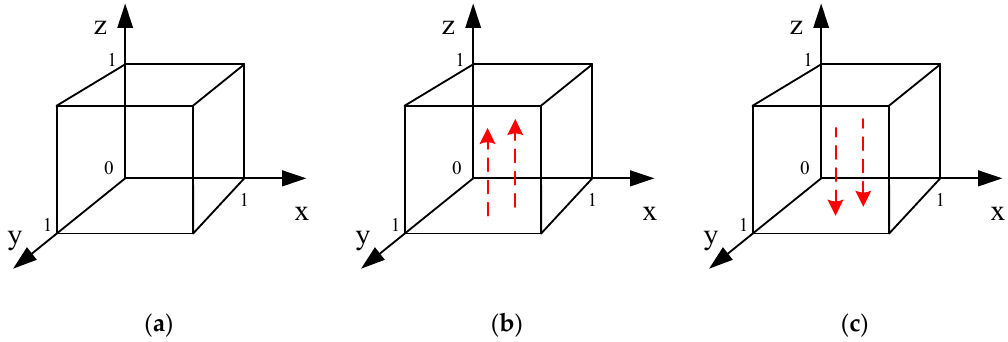
Figure 4. Dynamic evolution trend chart of potential demand-oriented enterprises.